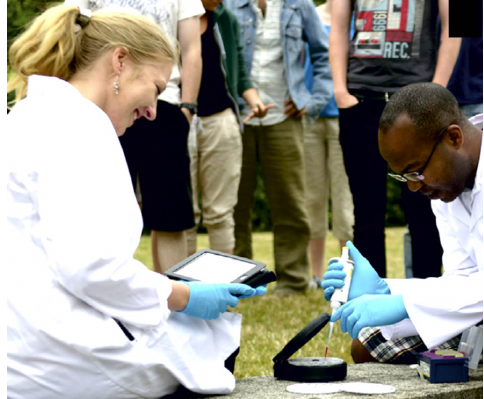
Figure 13. Testing of portable centrifugal microfluidic system for POC liver function testing in Nigeria. Reprinted from [117] with permission from